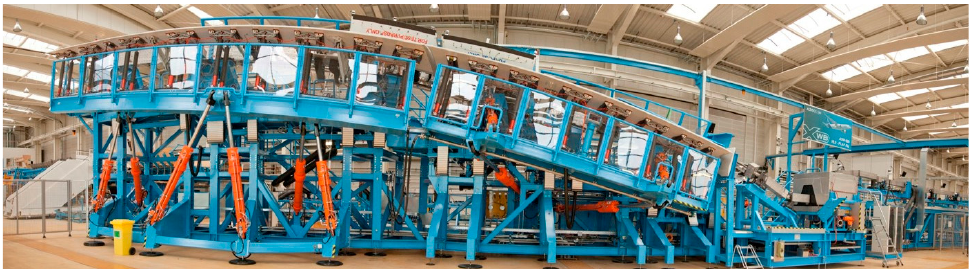
Figure 1. Airbus A350 Test Rig-Image from Airbus Operations GmbH.